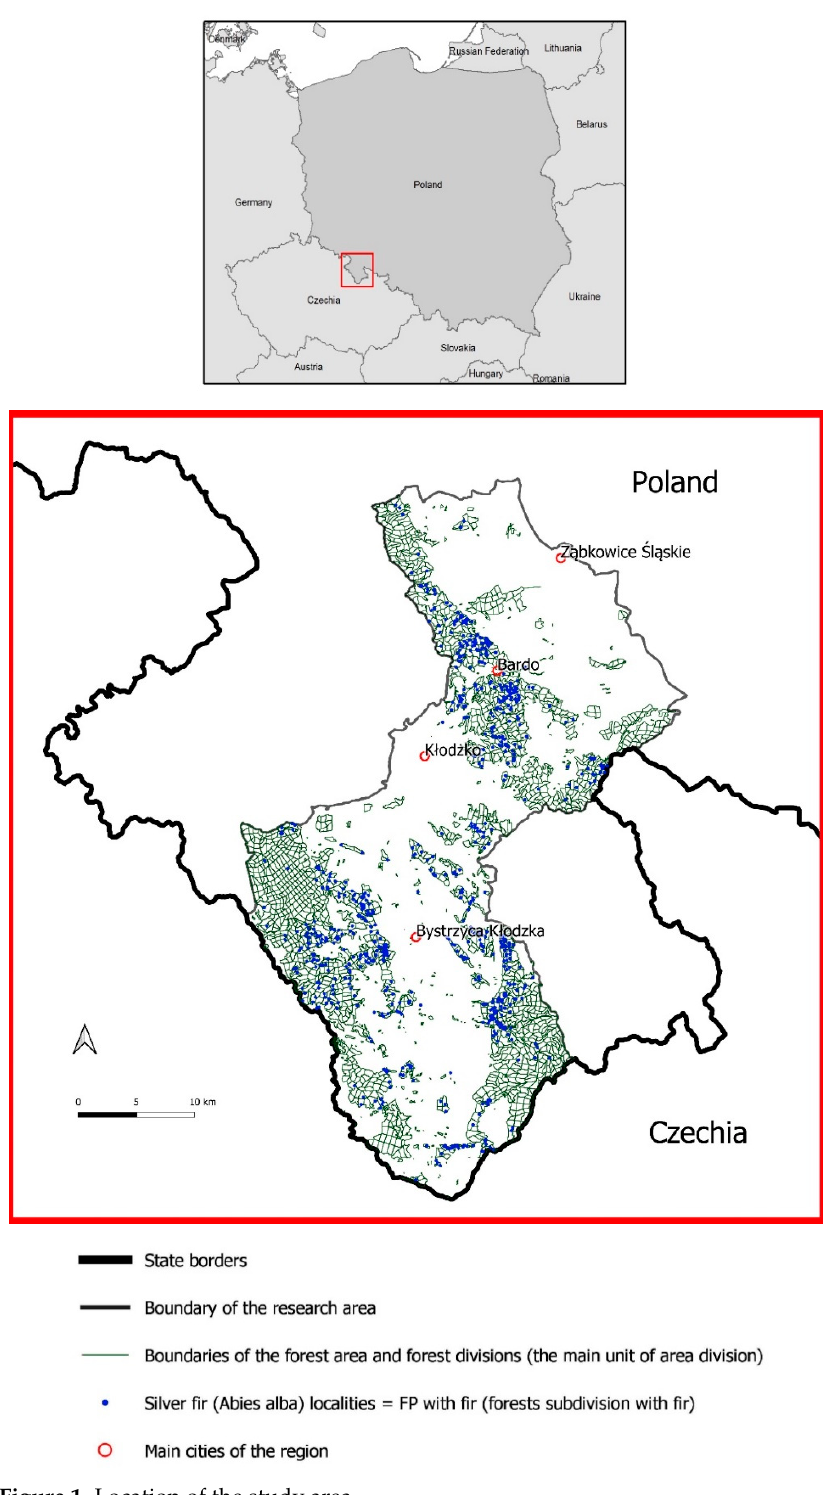
Figure 1. Location of the study